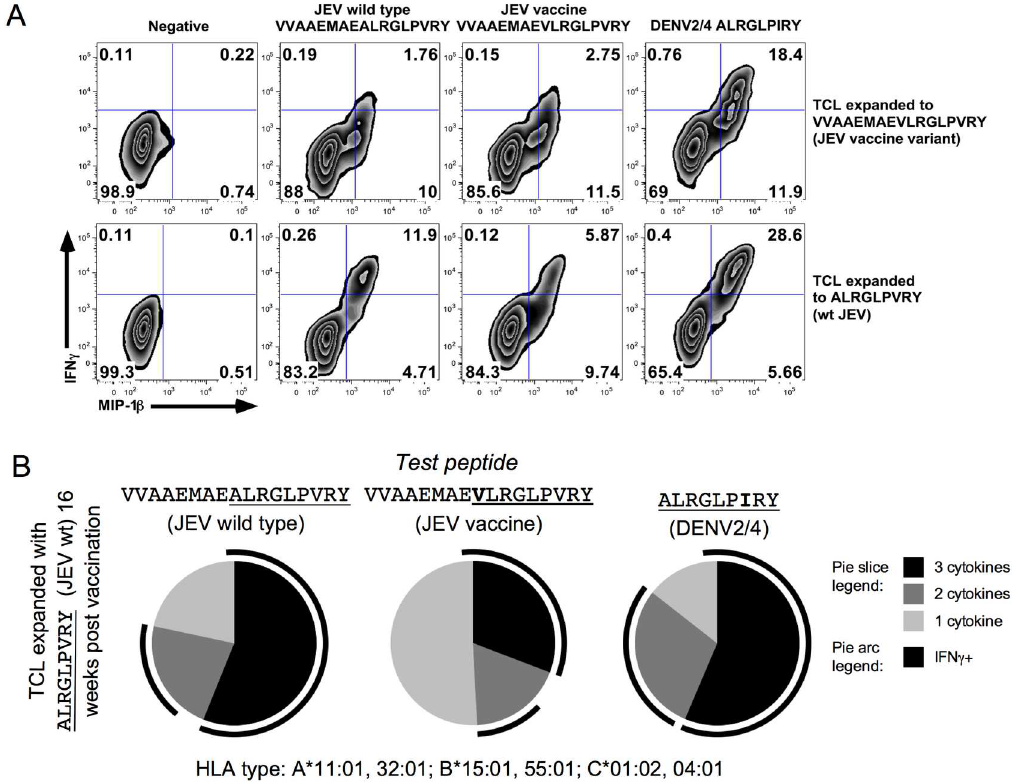
Fig 7. A sub-optimal cross-reactive CD8 + T cell response dominated by MIP-1 β single positive cells. (A) Flow cytometry data from the same experiment as Fig 6E. Data are log 10 fluorescence units, gated on live, CD3 + , CD8 + cells. (B) SPICE analysisof 16-weekpost vaccine TCL responses from the same experimentas in Fig 6E, stimulated with JEV wild type (left), JEV vaccine (centre) and DENV2/4 (right) peptides. Cells were stained for IFN γ , TNF α and MIP-1 β ; pie slices correspond to the relative proportionof the response made up of triple cytokine + cells (black), doublecytokine + cells and single cytokine + cells, which were exclusively MIP-1 β + in this experiment.